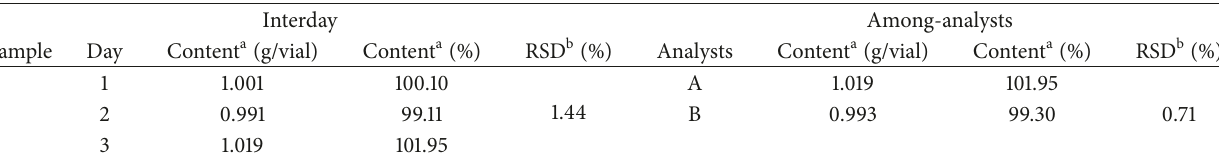
Table 2: Determination of the interday precision between analysts and for the UV spectrophotometric analysis of ceftriaxone sodium. Interday Among-analysts